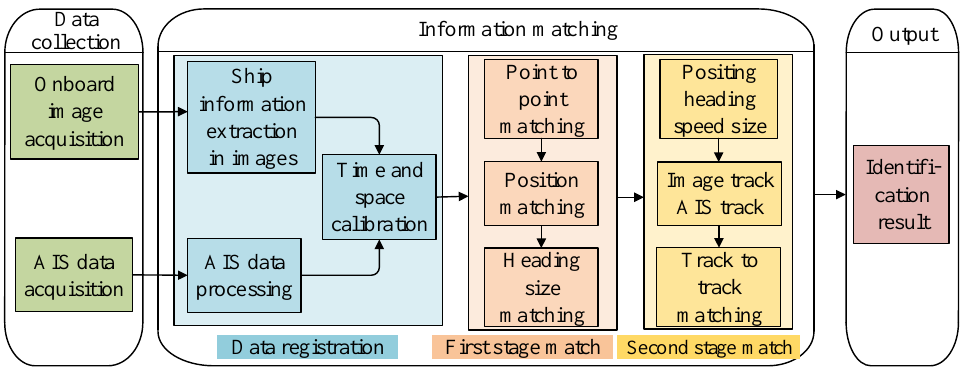
Figure 4. The matching model of the onboard image and AIS information.